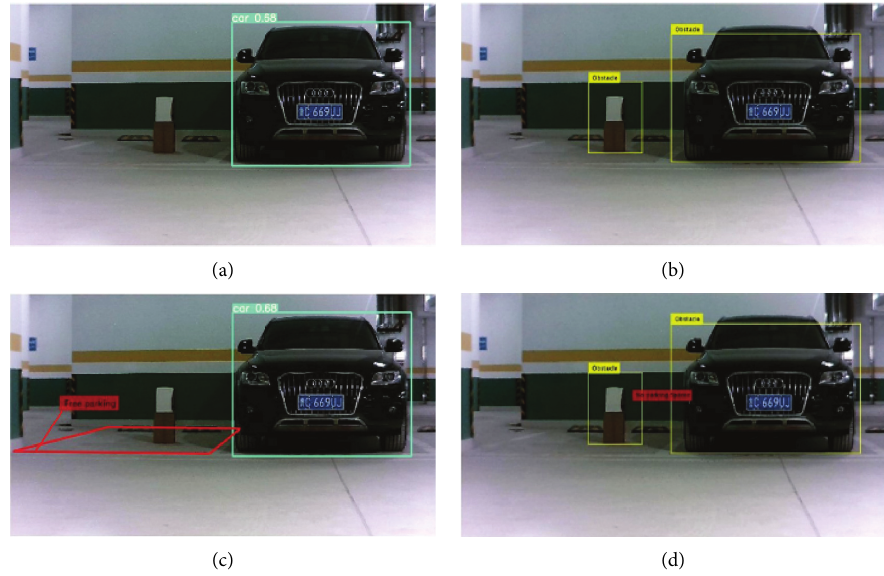
Figure 17: Parking detection based on VIDAR and YOLO v5. (a) Obstacle detection based on YOLO v5. (b) Obstacle detection based on